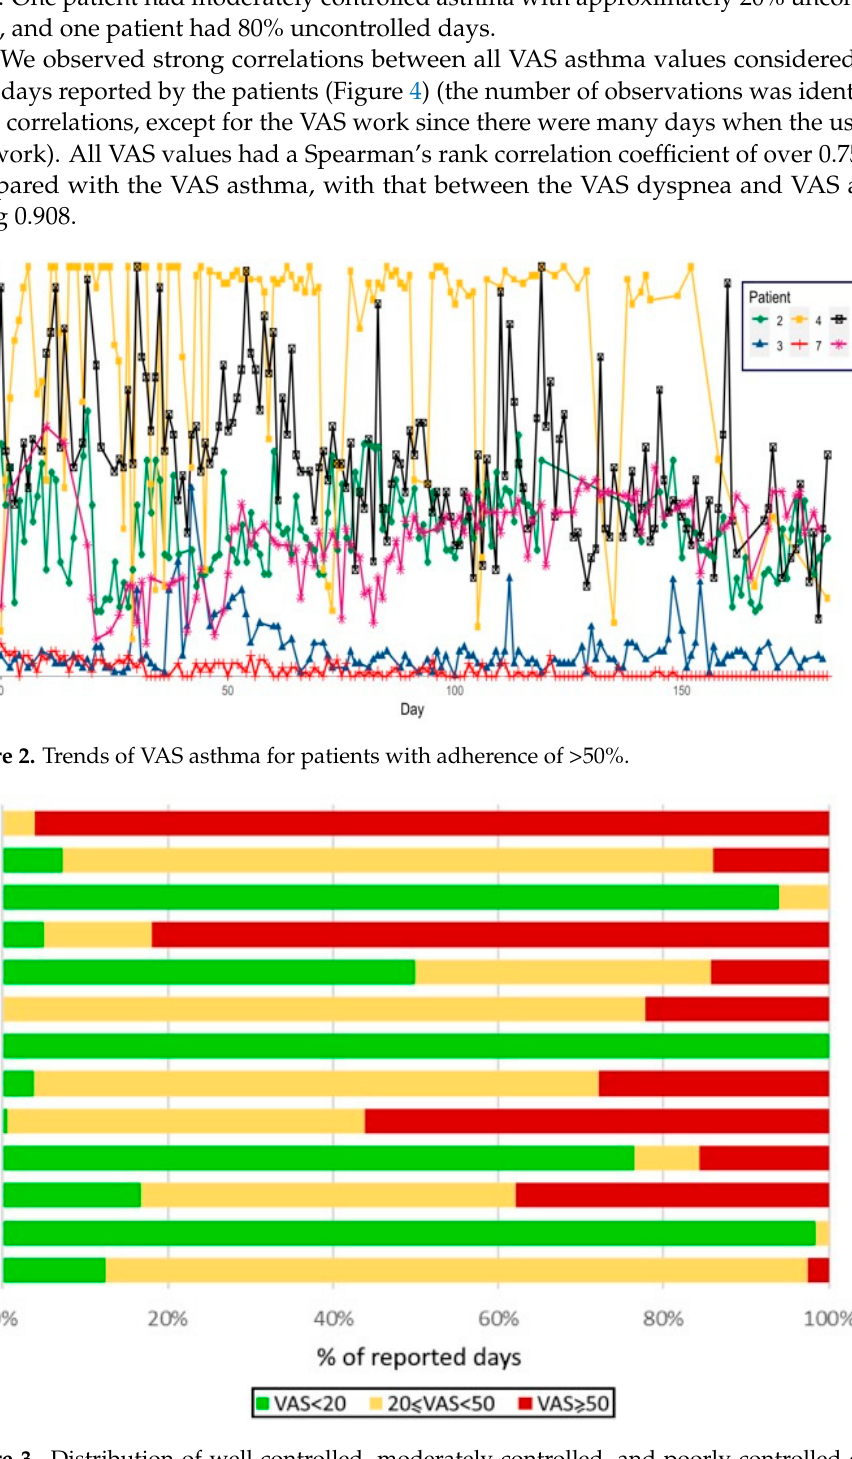
Figure 3. Distribution of well-controlled, moderately controlled, and poorly controlled days by patient, as assessed by the visual analogue scale (VAS) quantifying the severity of asthma symptoms. Table 2. Frequency of medication use.